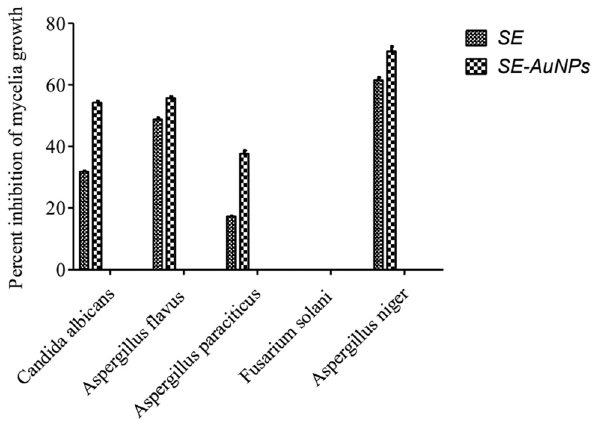
Figure 11: Fungicidal potency of SE and SE - mediated AuNPs against the di ff erent pathogenic fungal strains.